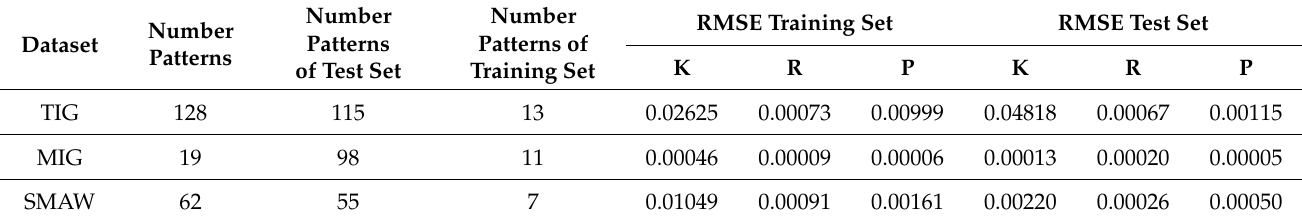
Table 9. Parameters for training network and root mean squared error (RMSE).